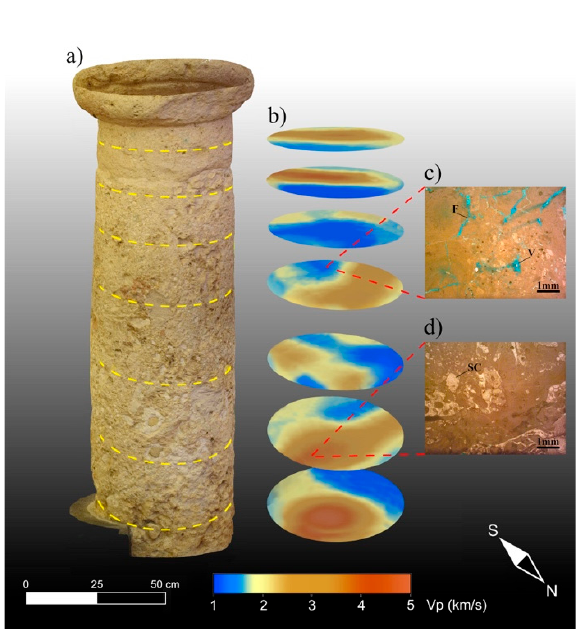
Figure 17. Integrated analysis of the ultrasonic tomography and thin sections for column 2. ( a ) CRP model; ( b ) tomographic slices; ( c ) thin section of the Pietra Forte in a sound sector of the shaft; ( d ) thin section of the Pietra Forte in a degraded sector of the shaft. F = fracture, V = vug, SC = sparry calcite